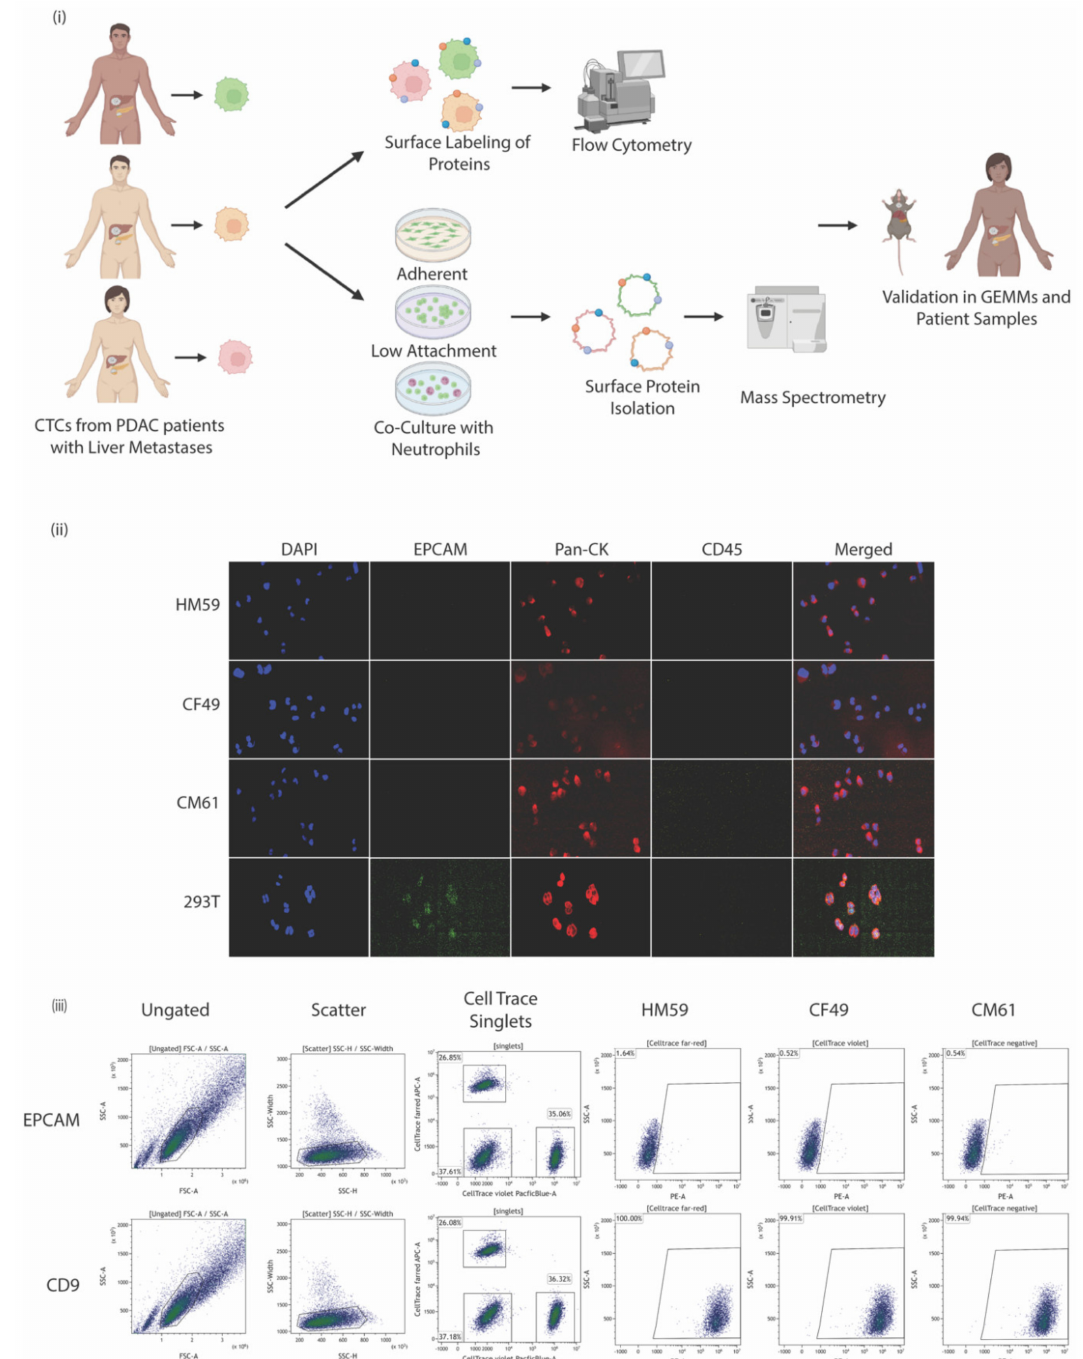
Figure 1. ( i ) Experimental pipeline indicating CTCs were isolated from peripheral blood of patients. The cells were either surface labeled to identify proteins by flow cytometry or were cultured under different conditions: as adherent cells or on low attachment plates as single cells or homogenous clusters, and as heterogeneous clusters in a co-culture with naïve neutrophils. The surface protein was isolated and subjected to mass spectrometry. ( ii ) Immunofluorescence labeling of patient-isolated CTCs compared with control CTCs stained for DAP1 nuclear stain, EpCAM, pan-cytokeratin, CD-45, and a merged composite image of all stains combined. ( iii ) Representative scatter plots for EpCAM, and CD9 staining on CTCs that were subjected to flow cytometry. Ungated, scatter, CellTrace plots and individual plots for the CTCs are